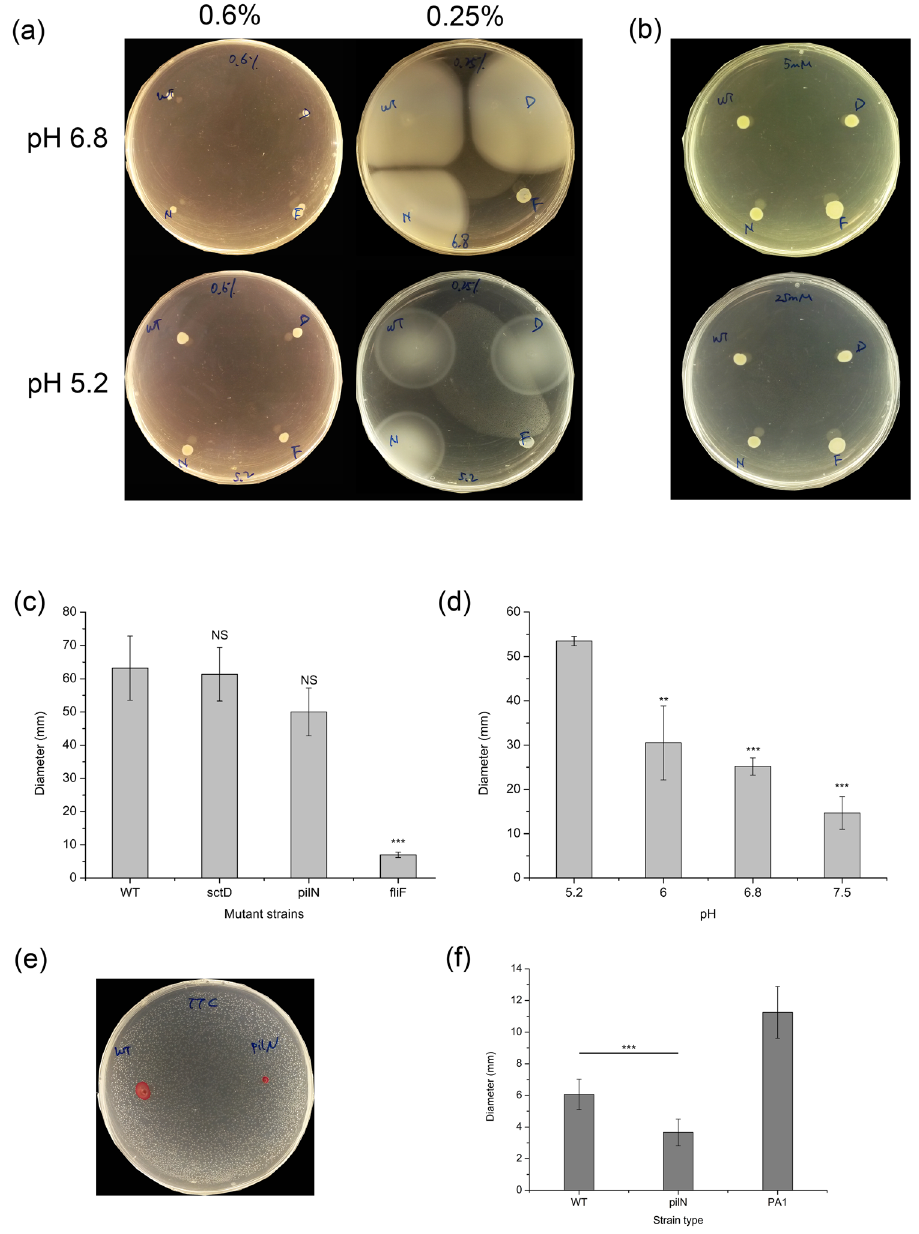
Figure 2. ( a ) Flagellar motility of B. terrae BS001 wild-type and mutant strains on soft agar medium. WT, wild- type strain; D, Δ sctD mutant strain; F, Δ fliF mutant strain; N, Δ pilN mutant strain. 0.25%, agar concentration 2.5 g/L; 0.6%, agar concentration 6 g/L. For swimming motility at pH 5.2, the image was obtained following overnight incubation, for the remainder, the pictures were taken 3 days after inoculation. ( b ) motility of B. terrae BS001 wild-type strain and mutant strains on swarming agar supplemented with 5 mM or 25 mM NaCl. ( c ) Swimming area (as described by diameter) of B. terrae BS001 wild-type and mutant strains on soft agar (2.5 g/L agar), 5 days after inoculation. ( d ) Swimming area of B. terrae BS001 wild-type strain on soft agar (2.5 g/L agar) at different pH, 24 h after inoculation. ( e ) Twitching motility of B. terrae BS001 wild-type and Δ pilN mutant strain (3 days after inoculation). ( f ) Twitching area of wild-type, Δ pilN mutant and P. aeruginosa PA1 (3 days after inoculation). * P < 0.05, ** P < 0.01, *** P < 0.001 compared to wild-type in ( c ) and ( f ), compared to pH 5.2 in ( d